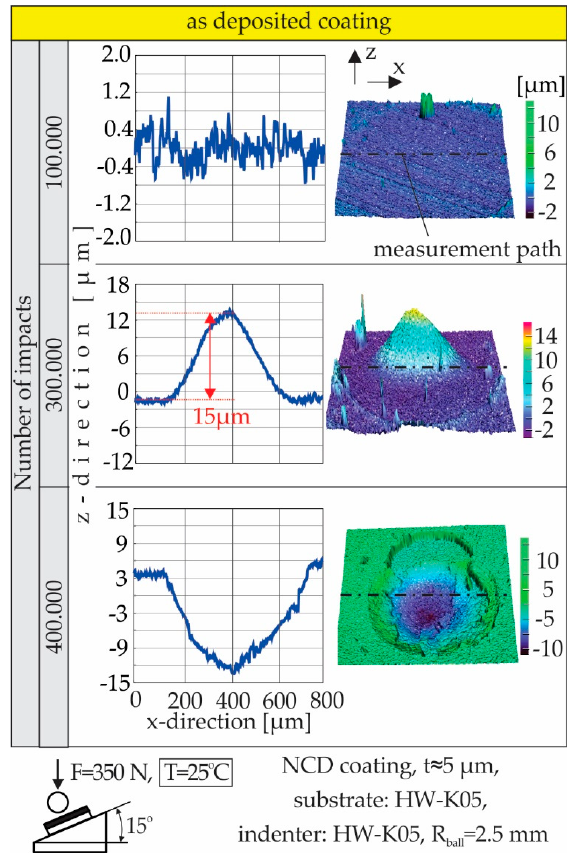
Figure 7. Impact test results on the as deposited nano-crystalline diamond (NCD) coated inserts at an impact load of 350 N after various number of impacts.